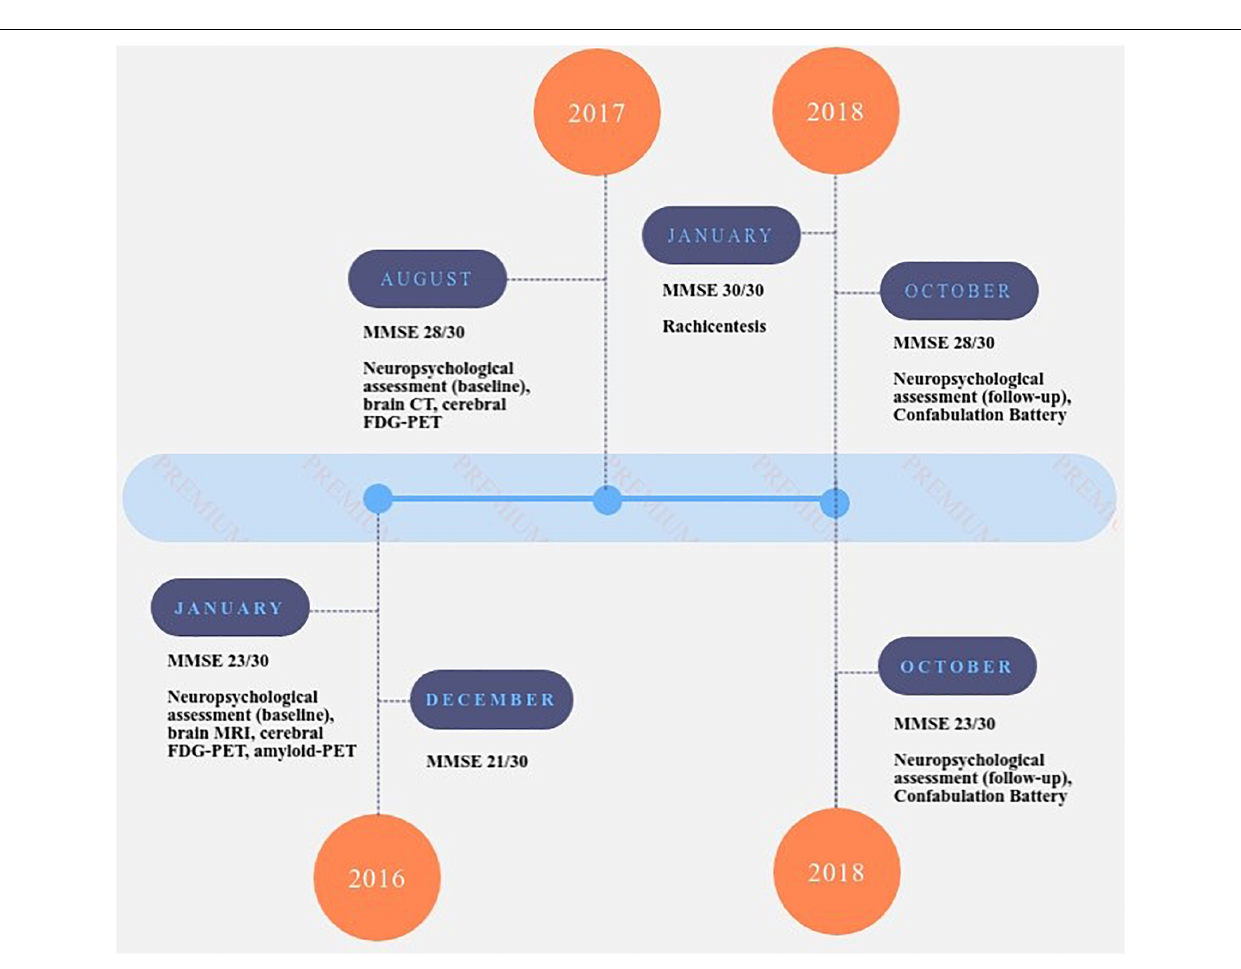
impairment and reduced performance in daily life activities, as confirmed by the AQ-D ( Table 1